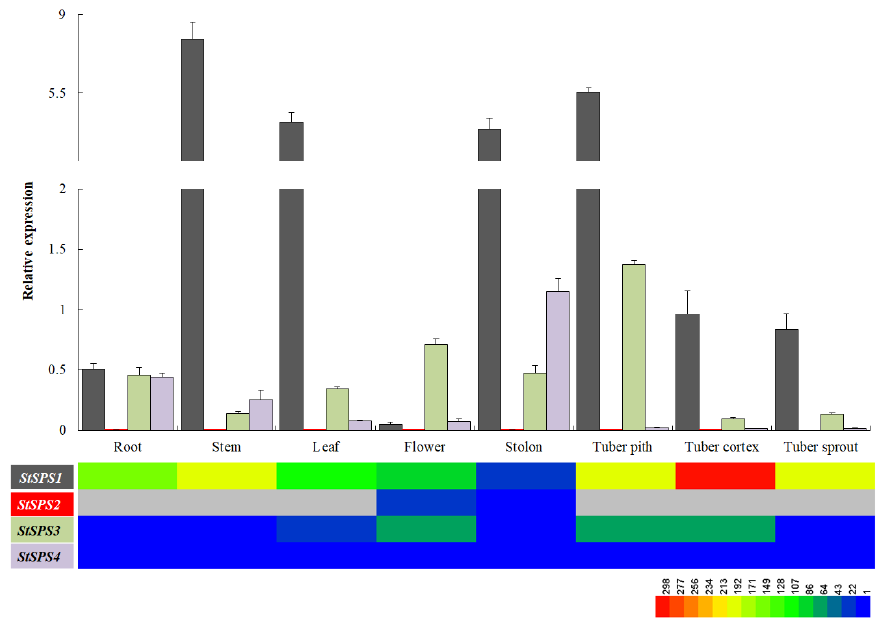
Figure 5. Expression analysis of StSPS family genes in different tissues (qRT-PCR). Flowers were sampled at the full flowering stage (70 d after planting), tuber sprout tissue was sampled after tuber sprouting (56 days storage), and other tissues were sampled at harvest time. The heat map below shows the tissue expression in the Ensembl Plants database.